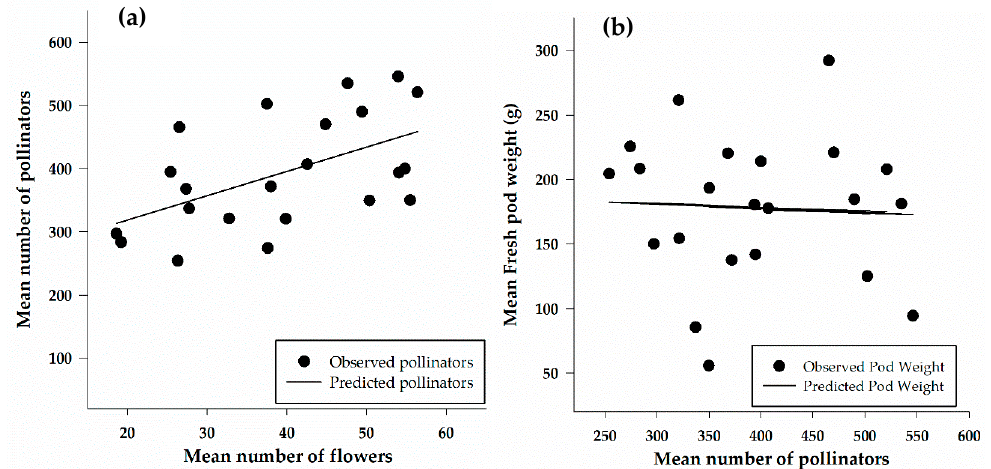
Figure 7. Linear regression showing the relationship between number of pollinators and number of flowers ( a ) ( y = 242.09 + 3.8x; n = 22; r 2 = 0.3; p = 0.01) and between fresh pod weight and number of pollinators ( b ) ( y = 193.72 − 0.04x; n = 22 ; r 2 = 0.004; p = 0.8).